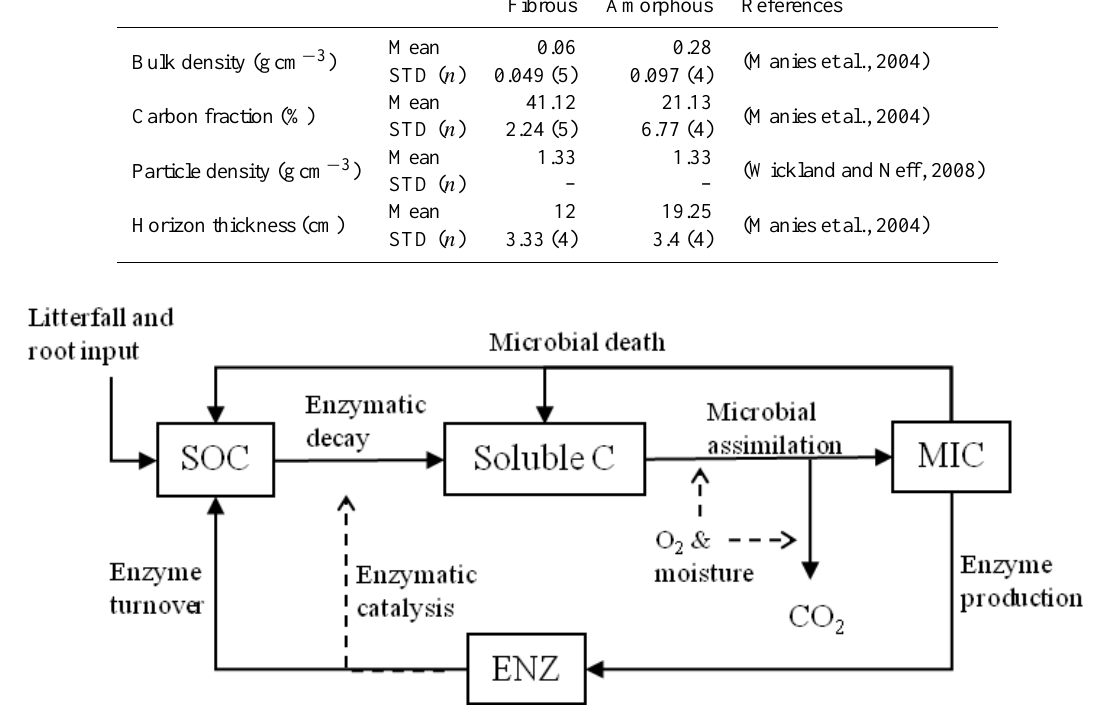
Figure 2. Conceptual representation of soil decomposition dynamic in each layer. Rectangles represent stocks; solid arrows denote C flows; dashed arrows represent other